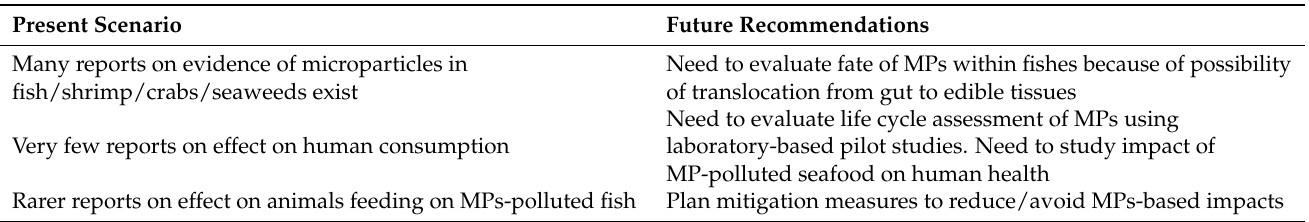
Table 3. Road map highlighting the known facts and future directions towards filling research